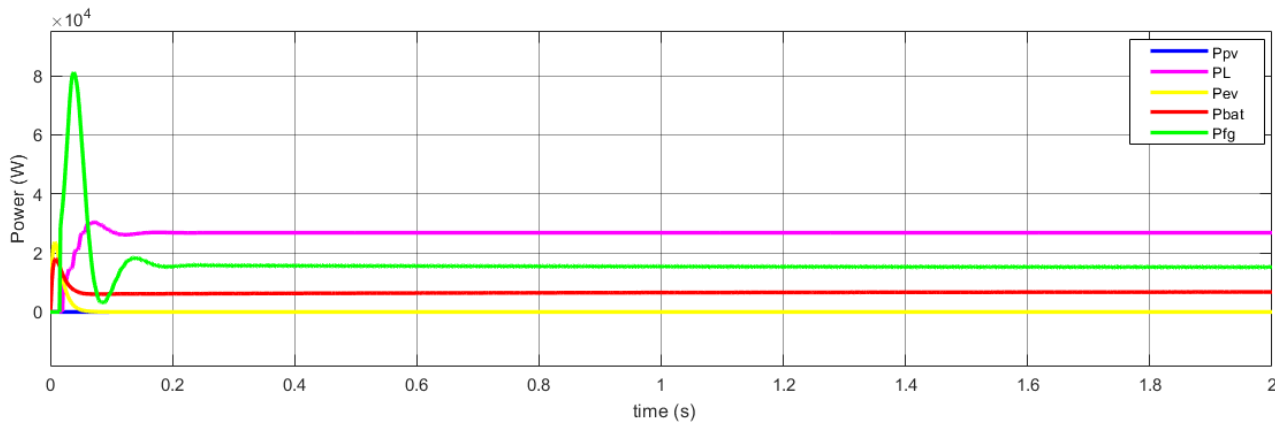
( b ) Figure 13. SOC of the EV and the storage ba tt ery. ( a ) EV SOC. ( b ) Storage ba tt ery SOC. In this case, the EV cannot operate in V2H mode because it is discharged. The grid power used is about 22.5 kW, compared to the previous case (case 2), the grid power has been used was just 8.5 kW. Therefore, the simulation results presented in Figure 12 show that the use of EV in V2H mode makes it possible to relieve the electrical grid. 4.2. EV Is Not Connected to Home PV power and storage ba tt ery power are not enough to supply residential loads, and the EV is not connected to the house, in this case the grid intervenes to ensure the